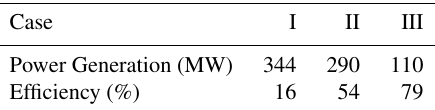
Table 3. Power generation (MW) and efficiency (%) for different wind farm cases. Power and efficiency are averaged over 5 sea- breeze days for 12:30 to